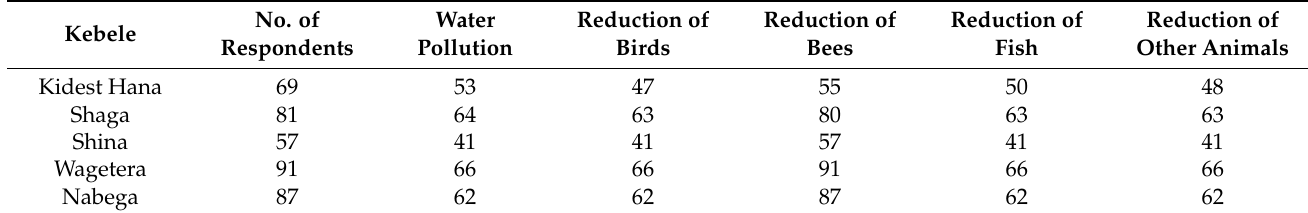
Table 6. Negative impacts of application of agricultural inputs.